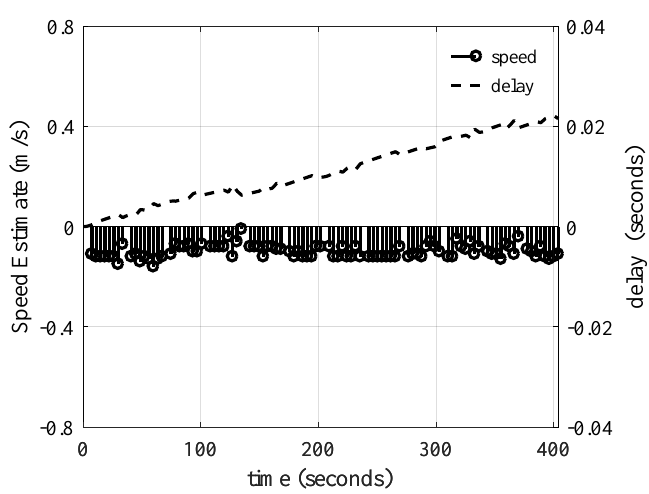
Figure 12. Output of the velocity estimation algorithm, and resulting symbol delay correction while the transmit vessel was drifting.